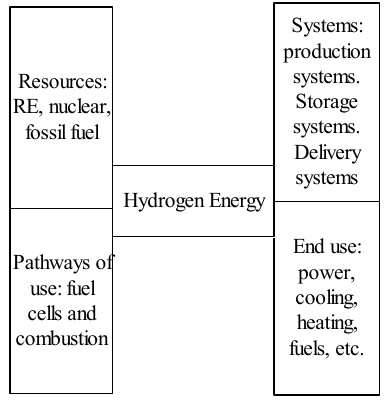
Figure 1. Hydrogen entire process stages.